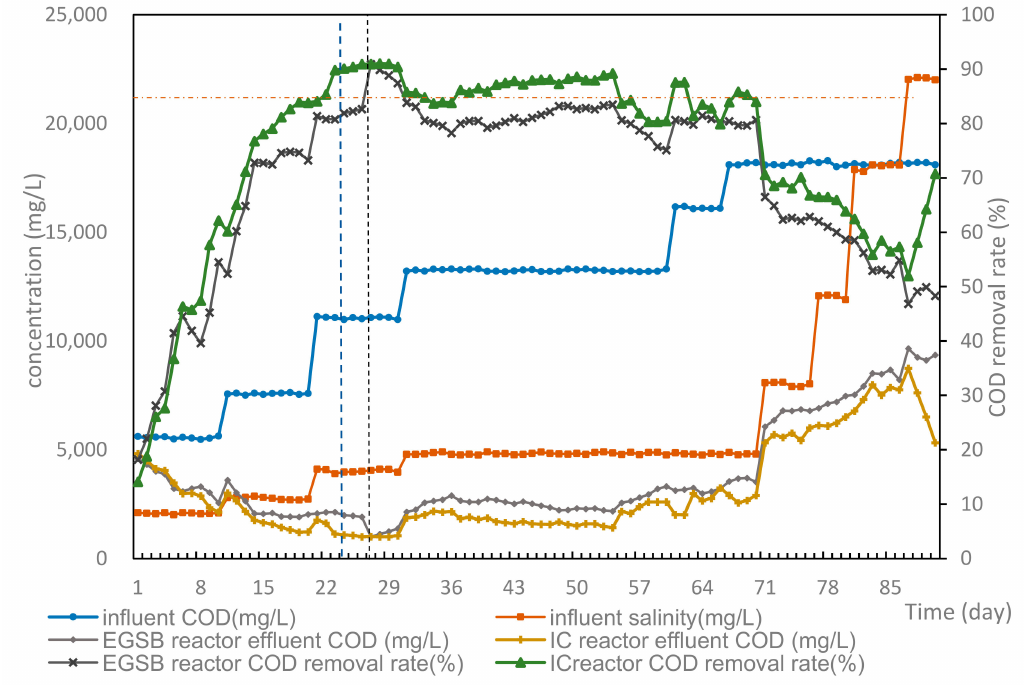
Figure 4. Relationship between the quality of influent water and the removal of COD in the two